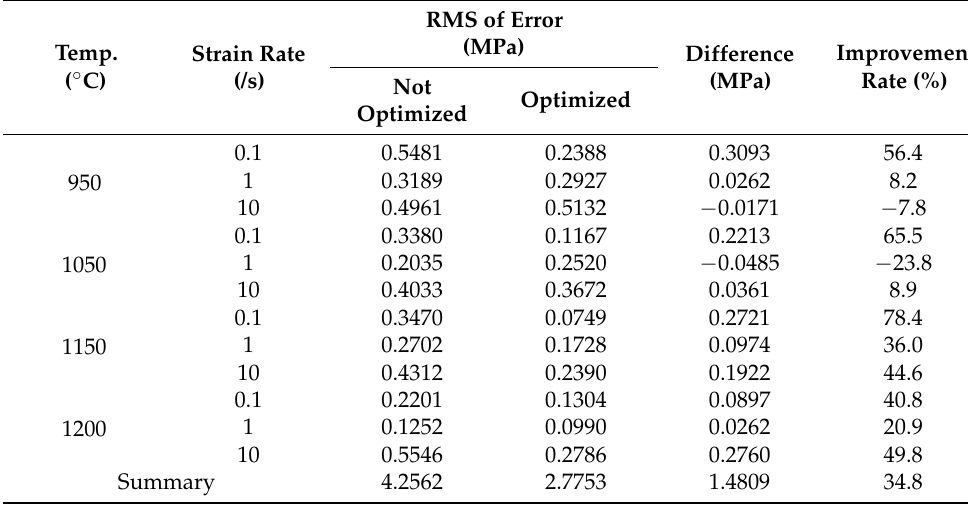
Table 2. Comparison of error of RMSE results before and after optimization.